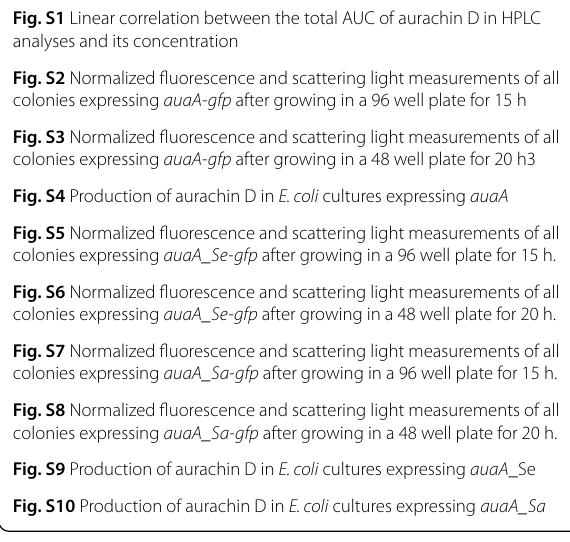
Fig. S1 Linear correlation between the total AUC of aurachin D in HPLC analyses and its concentration Fig. S2 Normalized fluorescence and scattering light measurements of all colonies expressing auaA-gfp after growing in a 96 well plate for 15 h Fig. S3 Normalized fluorescence and scattering light measurements of all colonies expressing auaA-gfp after growing in a 48 well plate for 20 h3 Fig. S4 Production of aurachin D in E. coli cultures expressing auaA Fig. S5 Normalized fluorescence and scattering light measurements of all colonies expressing auaA_Se-gfp after growing in a 96 well plate for 15 h. Fig. S6 Normalized fluorescence and scattering light measurements of all colonies expressing auaA_Se-gfp after growing in a 48 well plate for 20 h. Fig. S7 Normalized fluorescence and scattering light measurements of all colonies expressing auaA_Sa-gfp after growing in a 96 well plate for 15 h. Fig. S8 Normalized fluorescence and scattering light measurements of all colonies expressing auaA_Sa-gfp after growing in a 48 well plate for 20 h. Fig. S9 Production of aurachin D in E. coli cultures expressing auaA _Se Fig. S10 Production of aurachin D in E. coli cultures expressing auaA_Sa